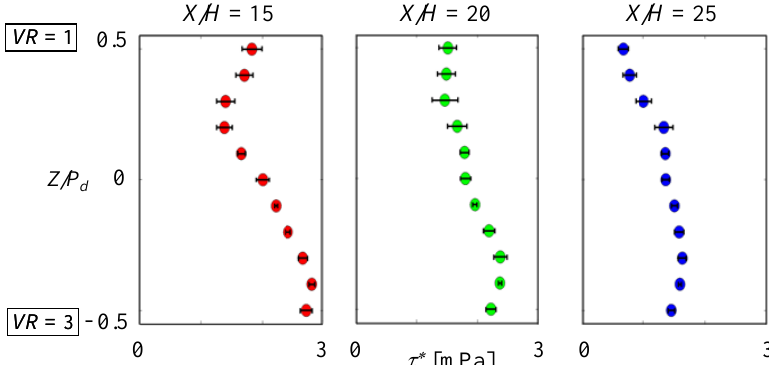
Fig. 9 Spanwise distribution of vortical strength of the transverse vortex   ) at X / H = 15, 20 and 25 in case 2 ( VR = 1 and 3) under Re =300 and F